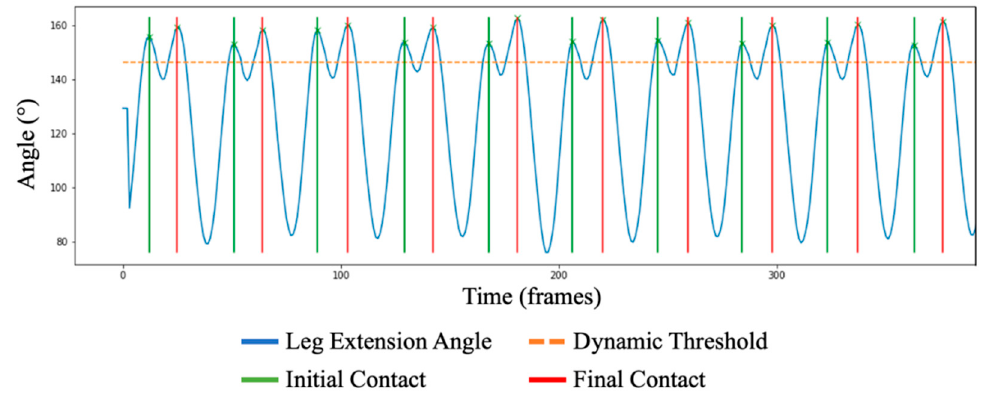
Figure 2. The identification of IC and FC, quantified by observing peaks within the leg extension angle data stream. Here, the dynamic threshold has been set at 90% of the maximum observed angle, wherein peaks are detected above the threshold. As seen, there is a significant angle reduction be- fore an IC, with a smaller reduction before FC; providing distinguishable features between the